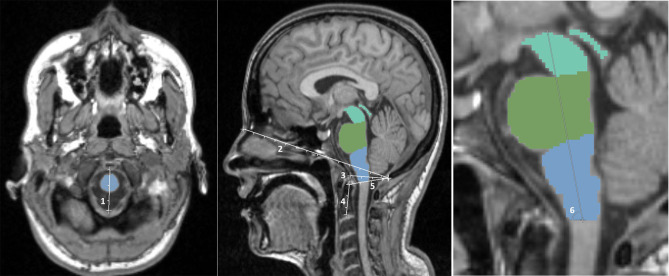
Illustration of the skull-based parameters foramen magnum diameter (1), nasion-opisthion (2), basion-opisthion (3), dens length (4), dens-opisthion (5), and brainstem angle (6).